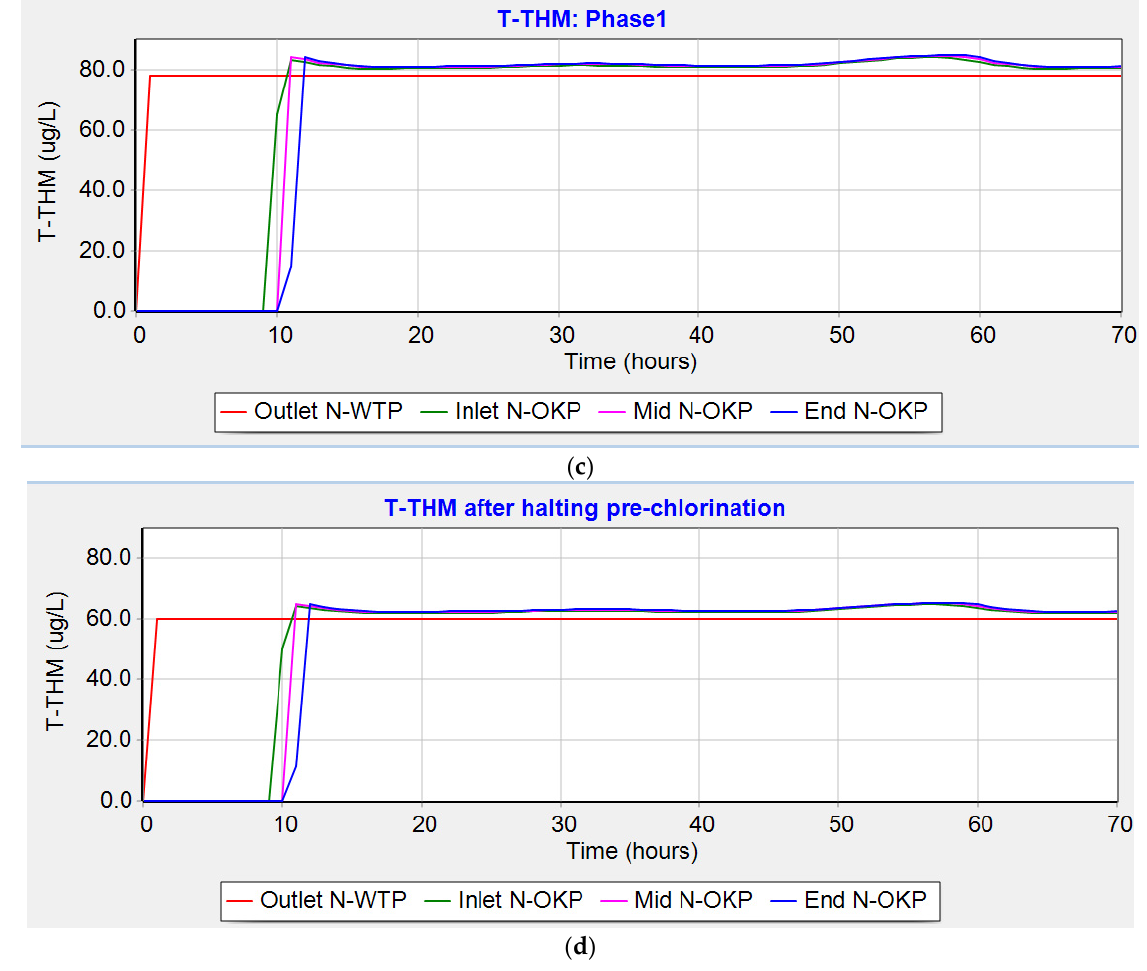
Figure 14. Simulation of trihalomethanes in Phase 1: ( a ) T-THM model; ( b ) T-THM in N-OKP area; ( c ) T-THM concentration with initial T-THM in treated water: 78 µg/L; ( d ) T-THM concentration in model after halting pre-chlorination: 60 µg/L.